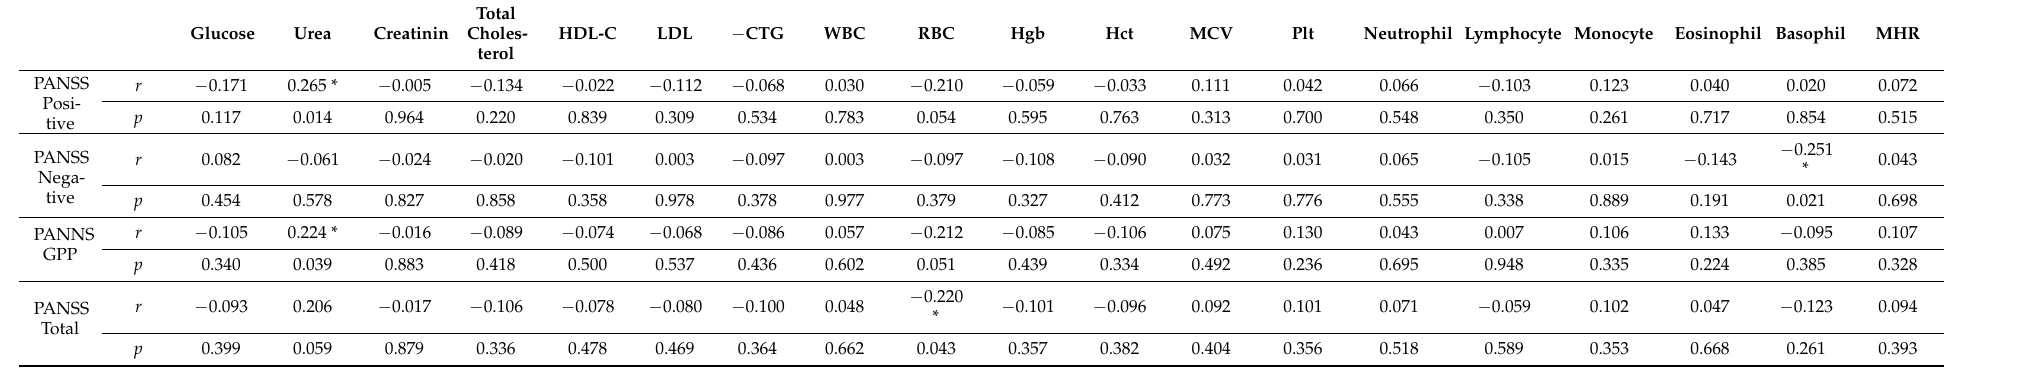
Abbreviations used in the table: HDL-C: high-density lipoprotein cholesterol, LDL-C: low-density lipoprotein cholesterol, TG: triglyceride, WBC: white blood cell (leukocyte) count, RBC: red blood cell (erythrocytes) count, Hgb: hemoglobin, Hct: hematocrit, MCV: mean corpuscular volume, Plt: platelet, MHR: monocyte/HDL-C ratio. Pearson correlation coefficient was used in the calculations. Values shown in the table; ‘ r ’ and ‘ p ’ values. * p < 0.05 was considered statistically